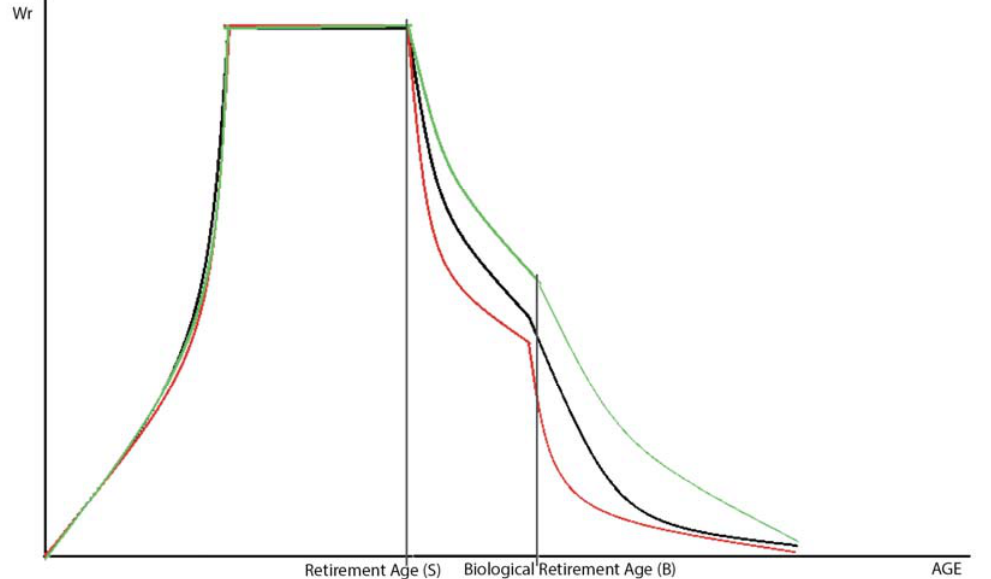
Figure 6. Effects of the rejuvenation rate on labor participation. Employment rate without BMTPR (BMTPR = 0) is represented by the black curve, with BMTPR (BMTPR ≠ 0) and RR/BMTPR << 1/2 is represented by red curve, with BMTPR (BMTPR ≠ 0) and RR/BMTPR >> 1/2 is represented by the green curve. The X-axis represents